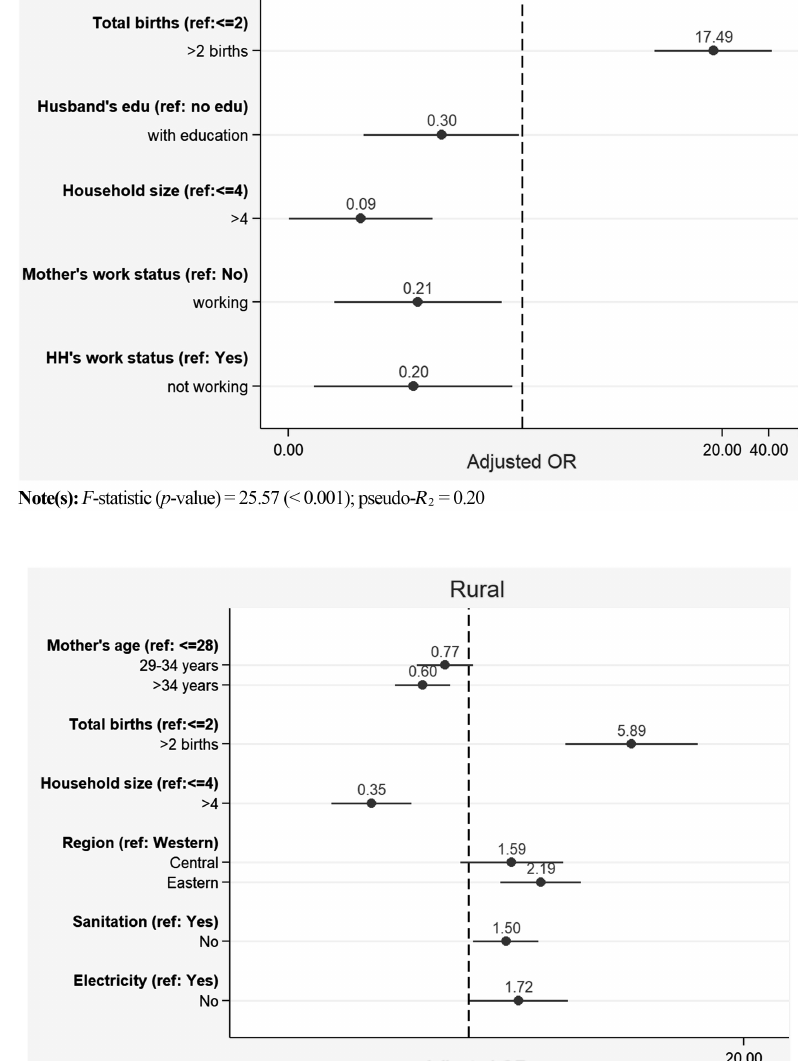
Figure 2. Adjusted association between under-five mortality and the determinants in rural